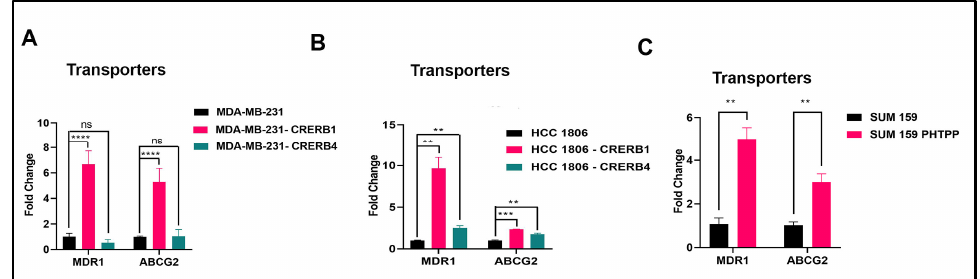
Figure 3. ABC transporters are regulated by ER β 1. ( A ). Quantitative real-time PCR analysis (qRT- PCR) of MDR1 and ABCG2 mRNA levels normalized to 36B4 in MDA-MB-231, MDA-MB-231 CRERB1, and MDA-MB-231 CRERB4 cell lines. Transporters are upregulated by truncating the ER β 1 LBD in MDA-MB-231 cells, while deleting the ER β 4 exon has no effect on transporter expression. ( B ). qRT-PCR analysis of transporters in HCC1806. MDR1 and to a lesser extent ABCG2 is upregulated in HCC1806 cells by ER β 1 LBD truncation while deleting the ER β 4 exon causes a slight increase in the transporter expression. ( C ). qPCR analysis of transporters in SUM159 WT and SUM159 treated with the ER β antagonist PHTPP, show upregulation of both MDR-1 and ABCG2. All results are shown as mean ± s.e.m. from three technical replicates. Data was analyzed using unpaired Two - tailed Student’s t -test. p -values: ** p < 0.01, *** p < 0.001, **** p < 0.0001 and ns = non- significant.